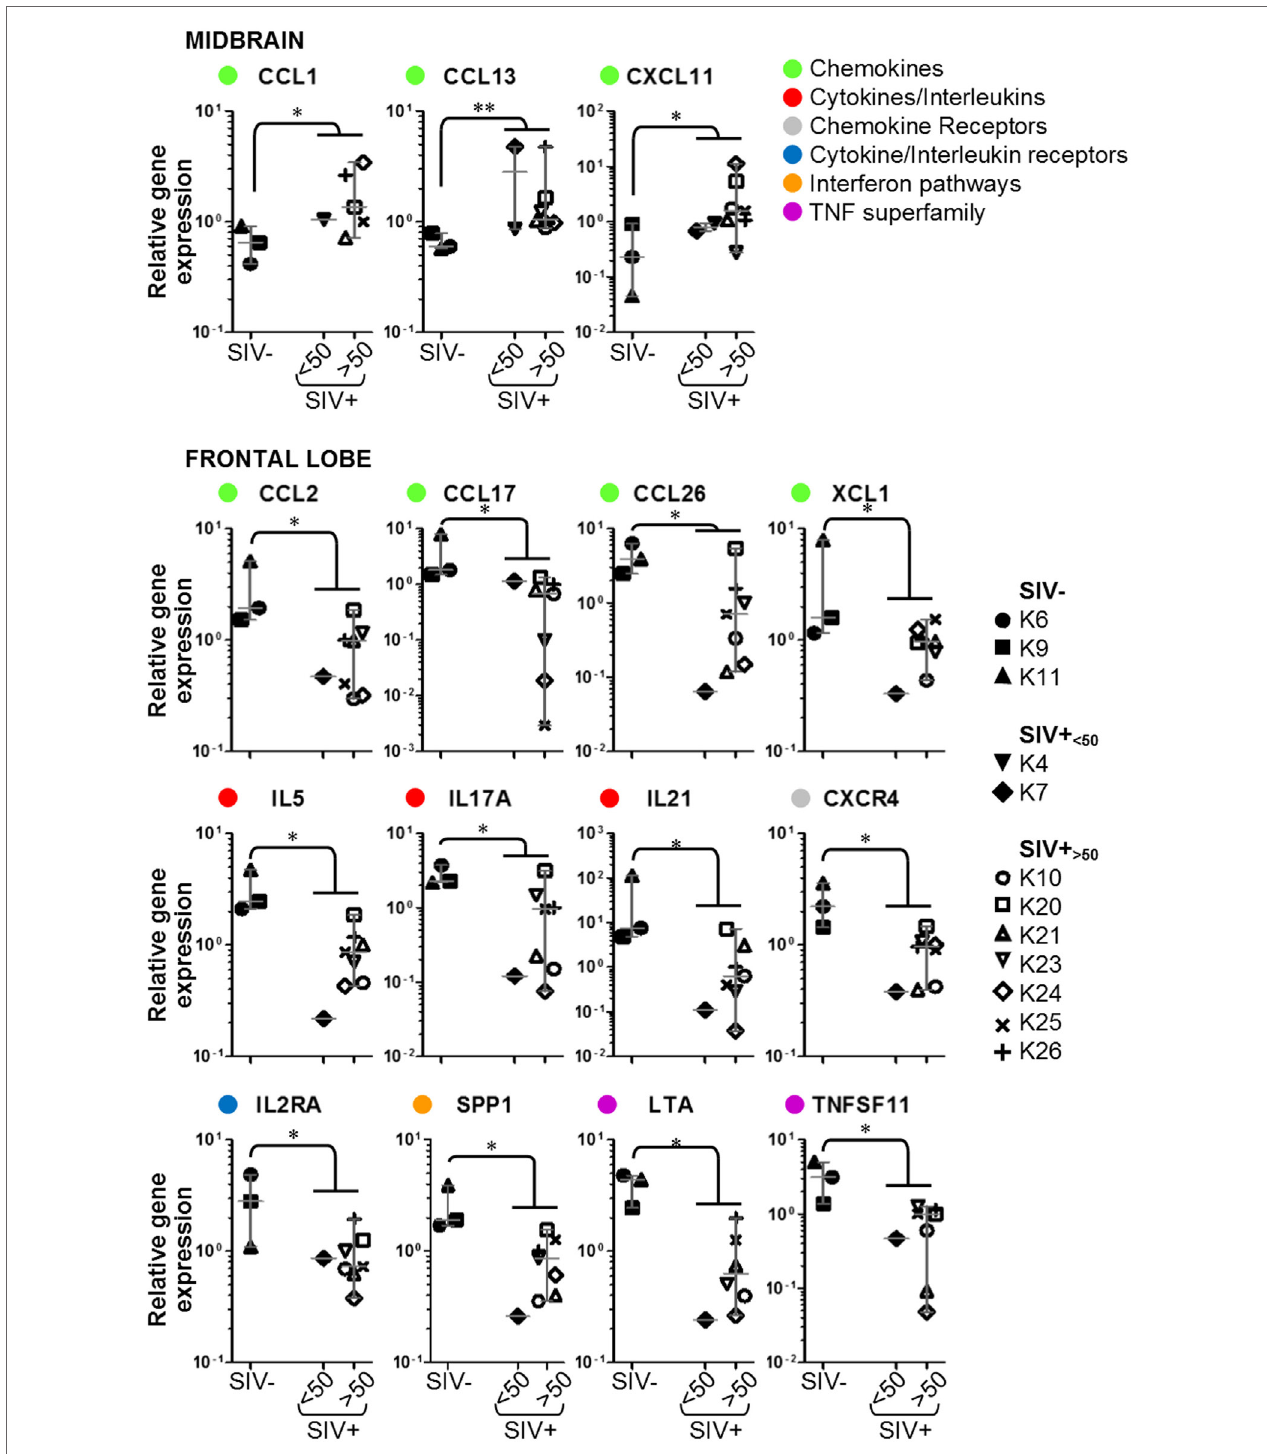
FigUre 3 | Details of inflammatory genes that are upregulated or downregulated in simian immunodeficiency virus (siV)-infected macaques . Dot plots showing relative expression of the genes in the red and green areas of Figure 2 for uninfected (SIV − ), SIV-infected aviraemic (SIV + < 50 ), and viremic (SIV + > 50 ) animals. All data are normalized against the median for all 12 animals. Each symbol indicates one animal as detailed in the legend; the legend refers to data from both midbrain and frontal lobe; horizontal gray lines within graphs indicate medians, and vertical gray lines show the interquartile ranges (* P < 0.05; ** P <